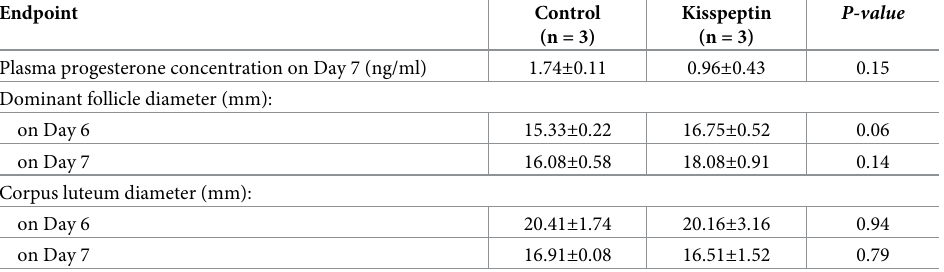
Table 1. Ovarian and endocrine responses (mean ± SEM) of lactating cows in proestrus treated with three iv injec- tions of 15mg human Kisspeptin-10 or normal saline (control) at 1h intervals on Day 7 (Day 0 = day of wave emer- gence) in Experiment 1. Data were compared by